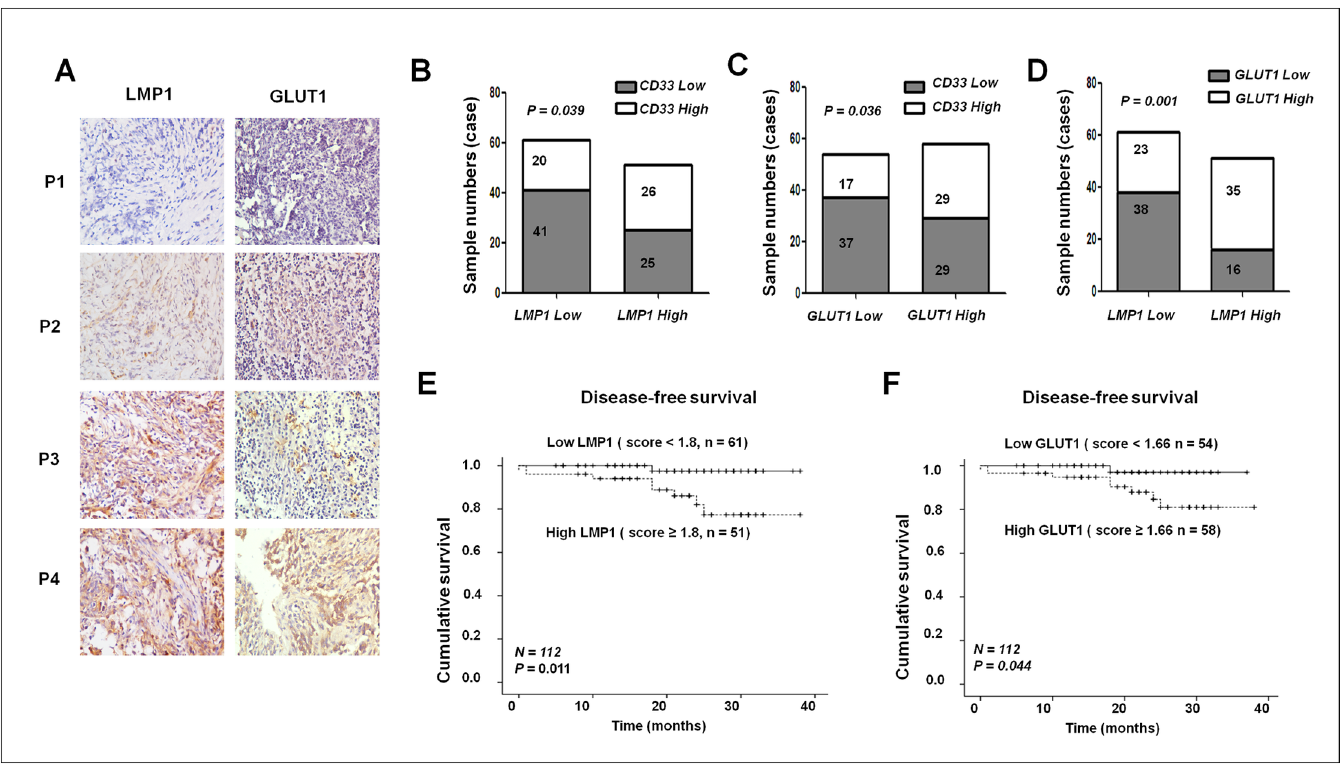
Fig 1. Positive correlations were observed between the abundance of LMP1 and GLUT1 in malignant cells and the number of CD33 + MDSCs in NPC tissues. ( A ) Representative IHC staining for LMP1 and GLUT1 in NPC specimens. ( B-D ) Statistical analysesof the correlations betweenLMP1 expressionand CD33 + MDSC number ( B ), GLUT1 expression and CD33 + MDSC number( C ), and LMP1 and GLUT1 expressionlevel ( D ), Pearson’s chi- square test was used to assess statistical significance. ( E-F ) Kaplan-Meier estimates of the progression-free interval were determinedbasedon the median levels of LMP1 ( E ) and GLUT1 ( F ) in the patients with NPC. P < 0.05 was considered statistically significant.